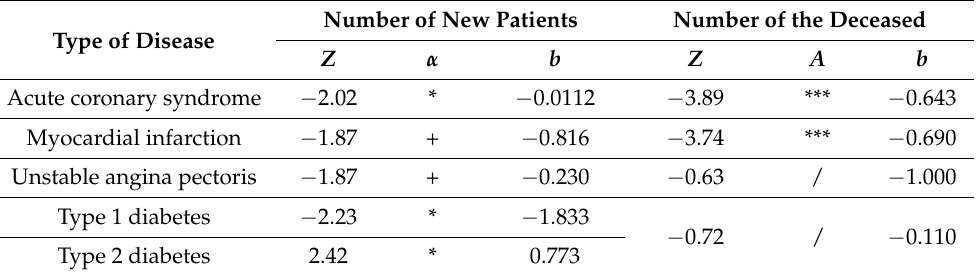
Parameters of the Mann—Kendall test for particular diseases in the researched area ( α —significance level, + α = 0.1, * α = 0.05, *** α = 0.001, /—no significance; b —so called Sen’s slope). Number of New Patients Number of the Type of Disease